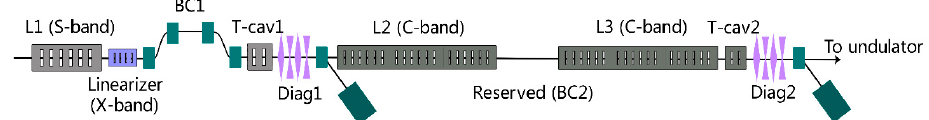
Figure 3. Layout of the main linac of the SXFEL-TF. (Reprint from reference [26])